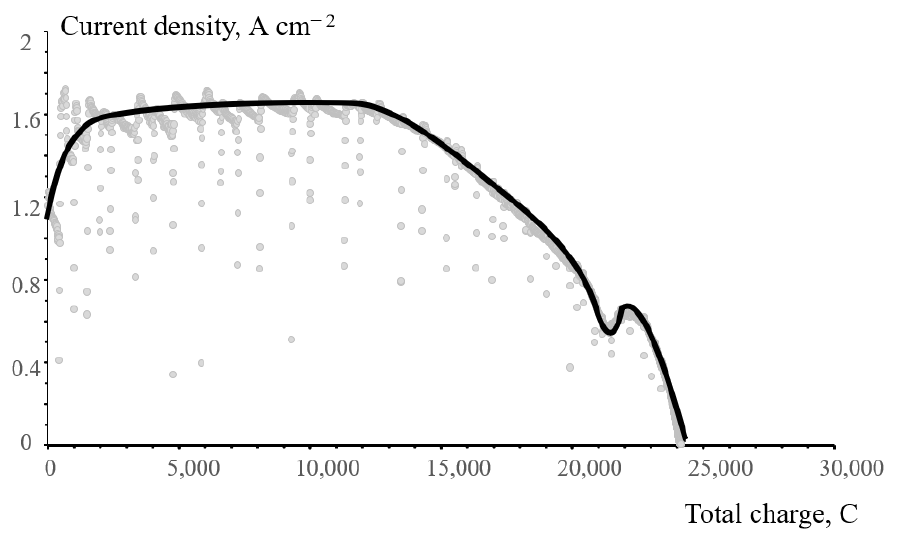
Figure 10. Discharge current density as a function of the total electric charge of a flow cell with a N211 membrane. The solid line is the approximated value of chaotic momentary fluctuations (pale gray points).